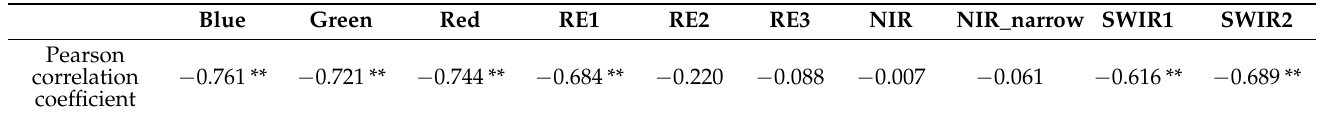
Table 4. Correlation coefficient matrix for spectrum features and CC.